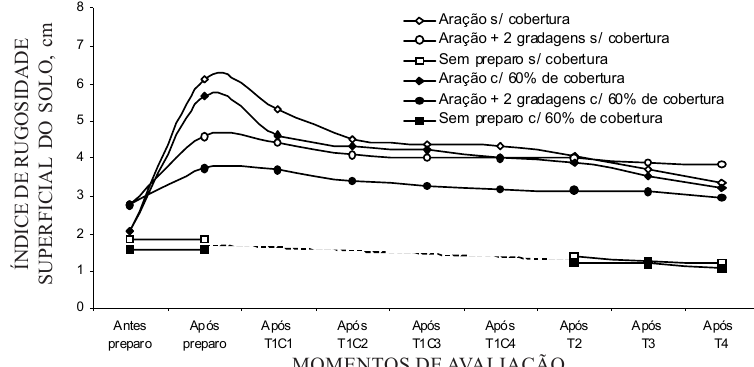
Figura 1. Índice de rugosidade superficial do solo no decorrer do experimento (T1, T2, T3 e T4 = testes de chuva 1, 2, 3 e 4, aplicados logo, 1, 20 e 35 dias após o preparo do solo, respectivamente; C1, C2, C3 e C4 = segmentos de chuva 1, 2, 3 e 4 de T1, com durações de 20, 20, 30 e 30 min, respectivamente; as chuvas dos Testes 2, 3 e 4 foram contínuas e tiveram 90 min de